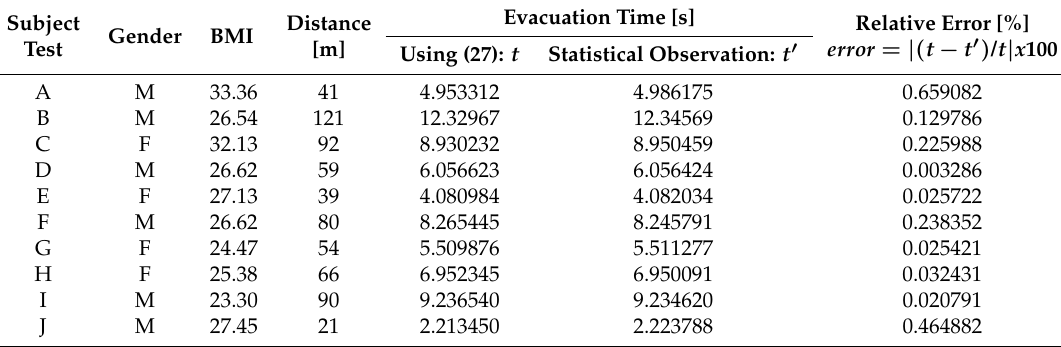
Figure 7. Predicting evacuation times with Gaussian Process Regression (GPR). Table 3. Evacuation time